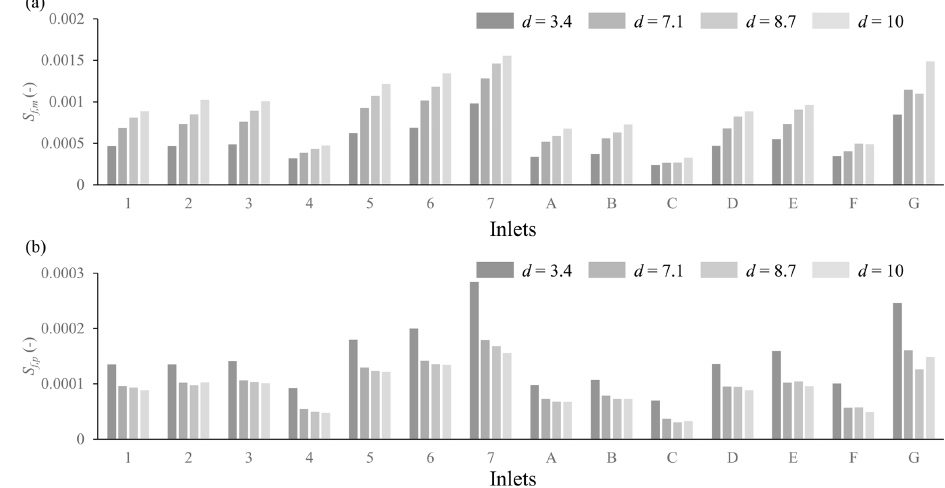
Figure 7. Distortion effect on energy slope of (a) scale models and (b) the model in prototype (dataset of Araud,